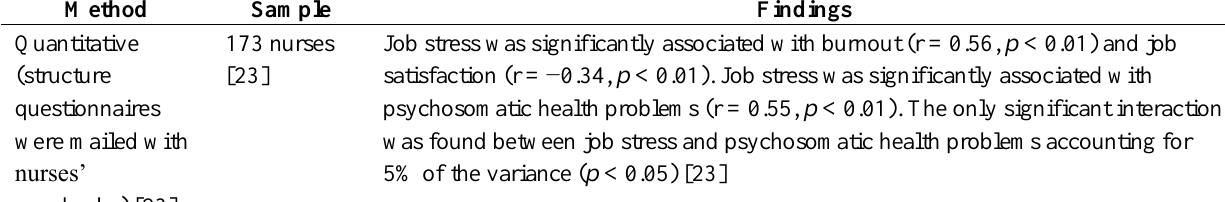
Table 11. Method, sample and findings of identified